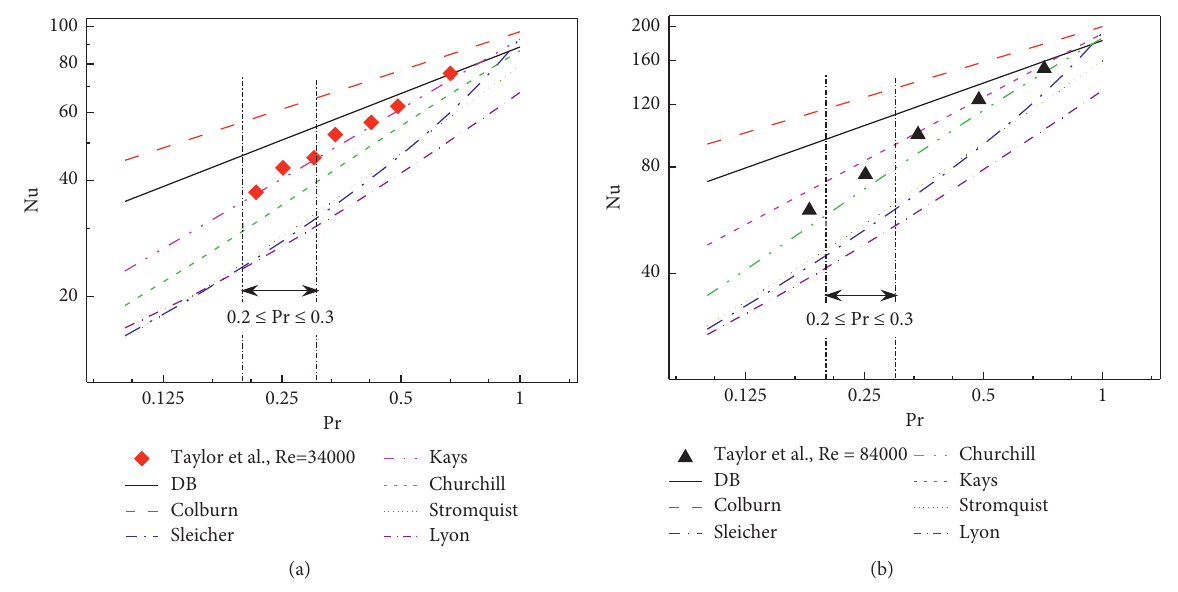
Figure 15: Comparison of calculations by Nusselt number correlations and experimental